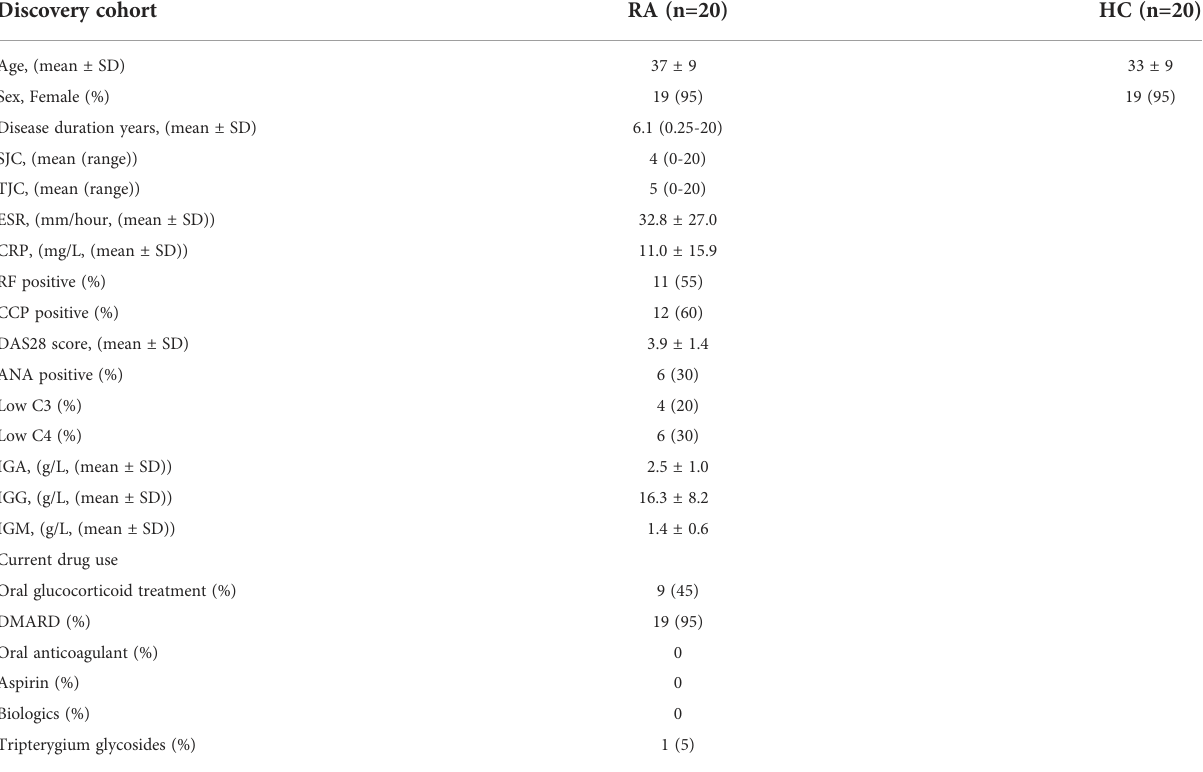
TABLE 4 Clinicopathologic characteristics of the RA patients and HC donors from validation cohort. Discovery